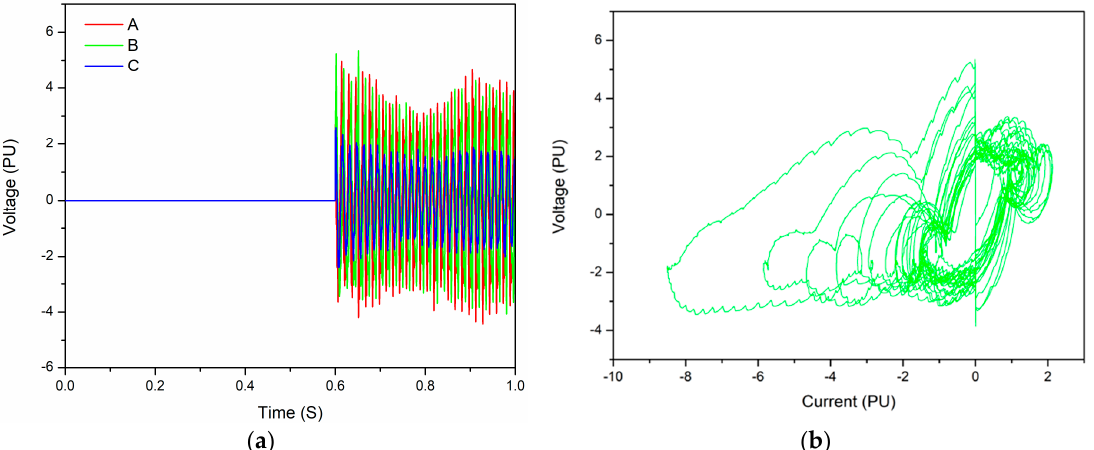
Figure 12. The ferroresonant results during energization on the DFIG wind turbine: ( a ) Voltage waveform having highest overvoltage on phase B; ( b ) Phase plane diagram of phase B depicting quasi ‐ periodic mode.